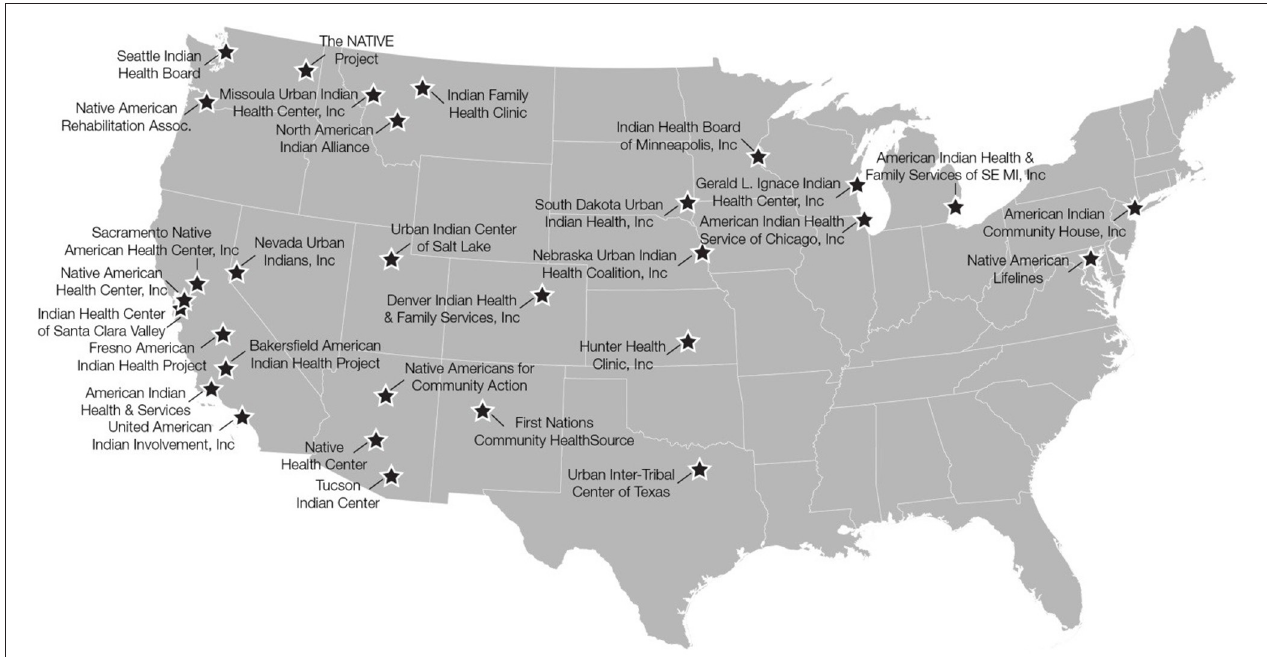
FIGURE 2 | Urban Indian Health Organization diabetes capacity survey